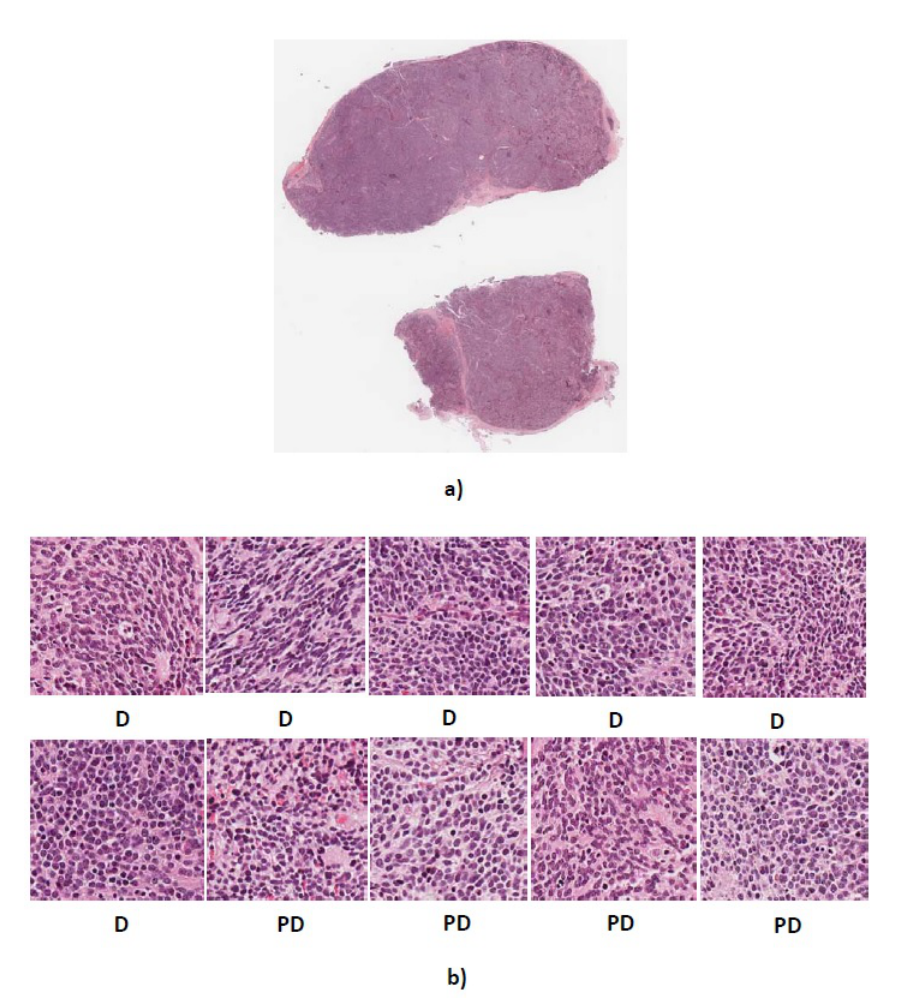
Figure 11. ( a ) Whole tissue section 4906 with actual label PD ( b ) Predicted labels for ten randomly cropped images from whole tissue section. D, differentiating neuroblastoma; PD, poorly-differentiated